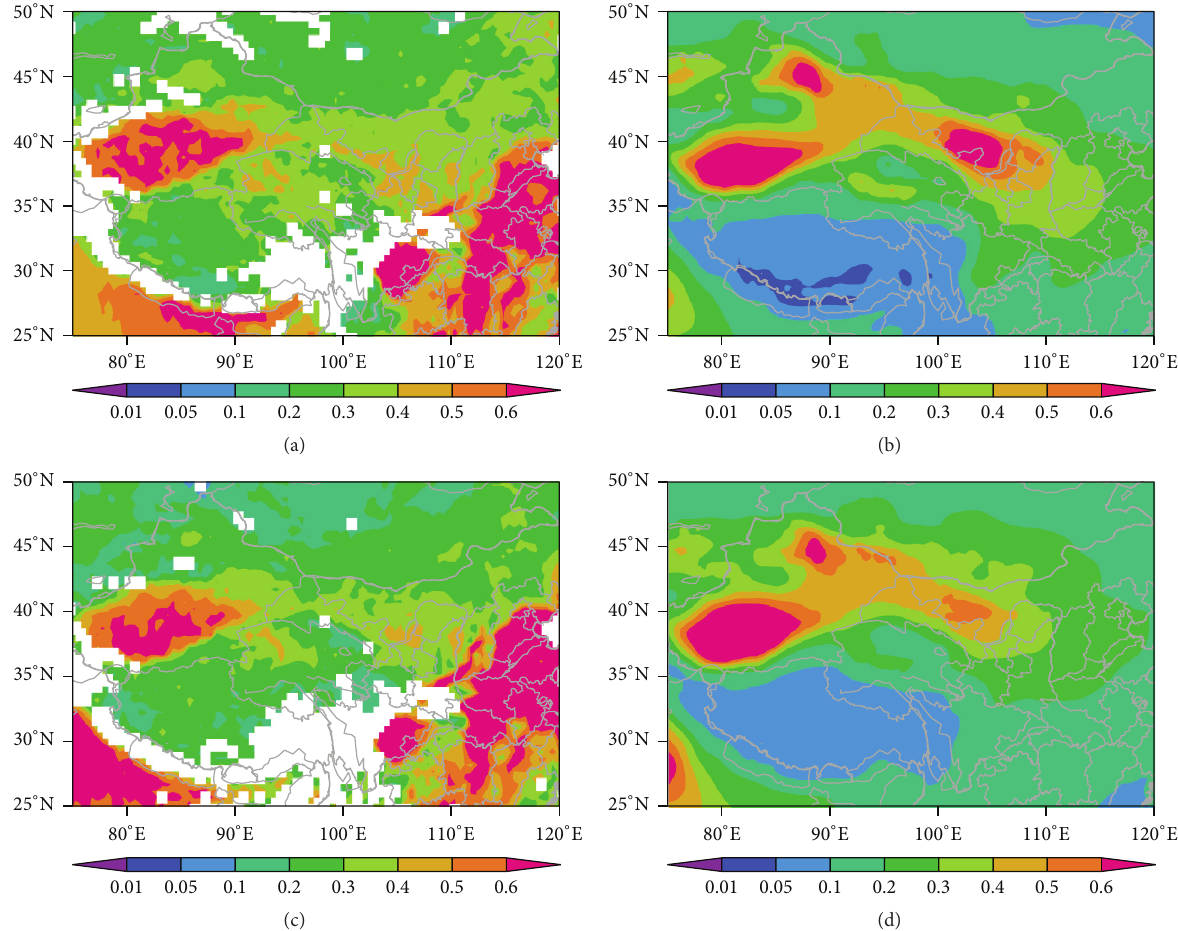
Figure 5: MISR-observed aerosol optical depth (a, c) and simulated dust AOD (b, d) averaged in spring (a, b) and summer (c, d) during